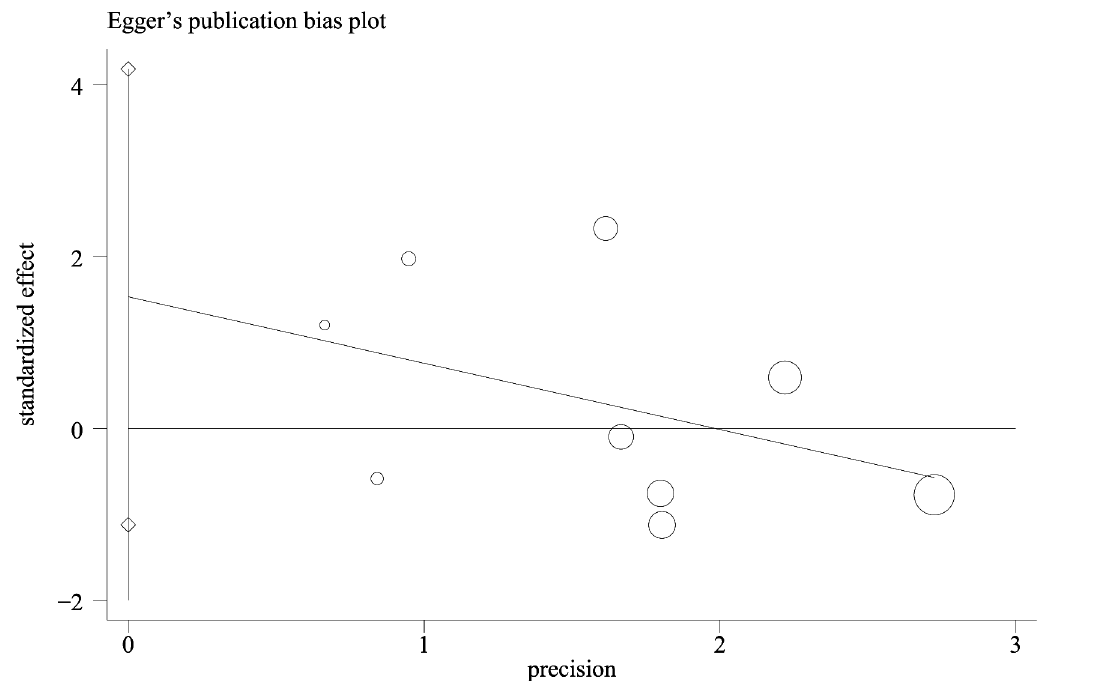
Fig 5. Egger ’ s publication bias